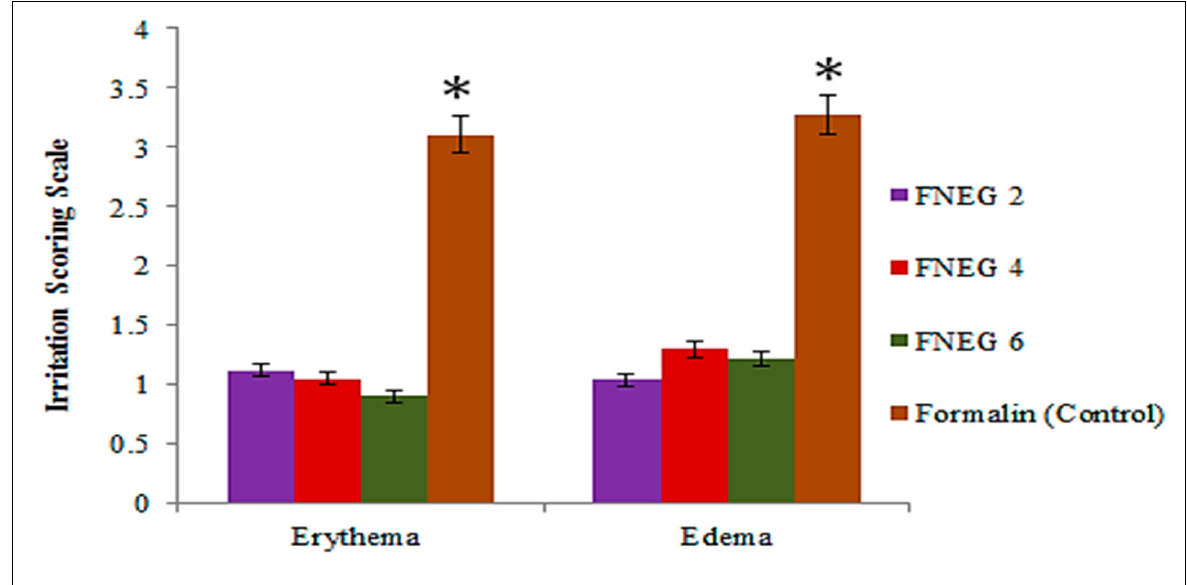
Figure 5. Skin irritation studies: erythema and edema. Data expressed as mean ± SD; n = 3. One-way ANOVA followed by post hoc Tukey test; * p < 0.05).